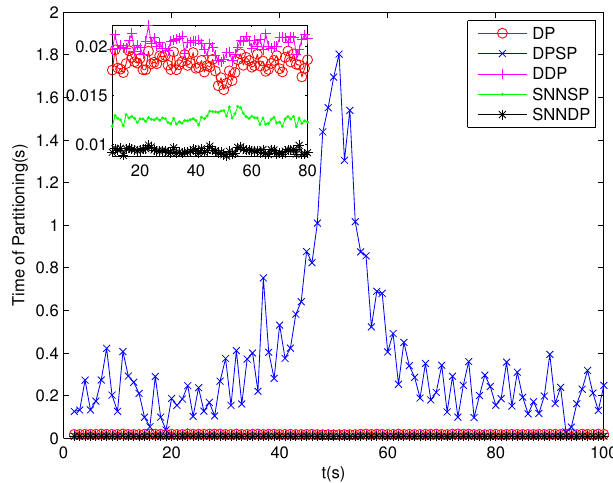
Figure 12. Computational time of